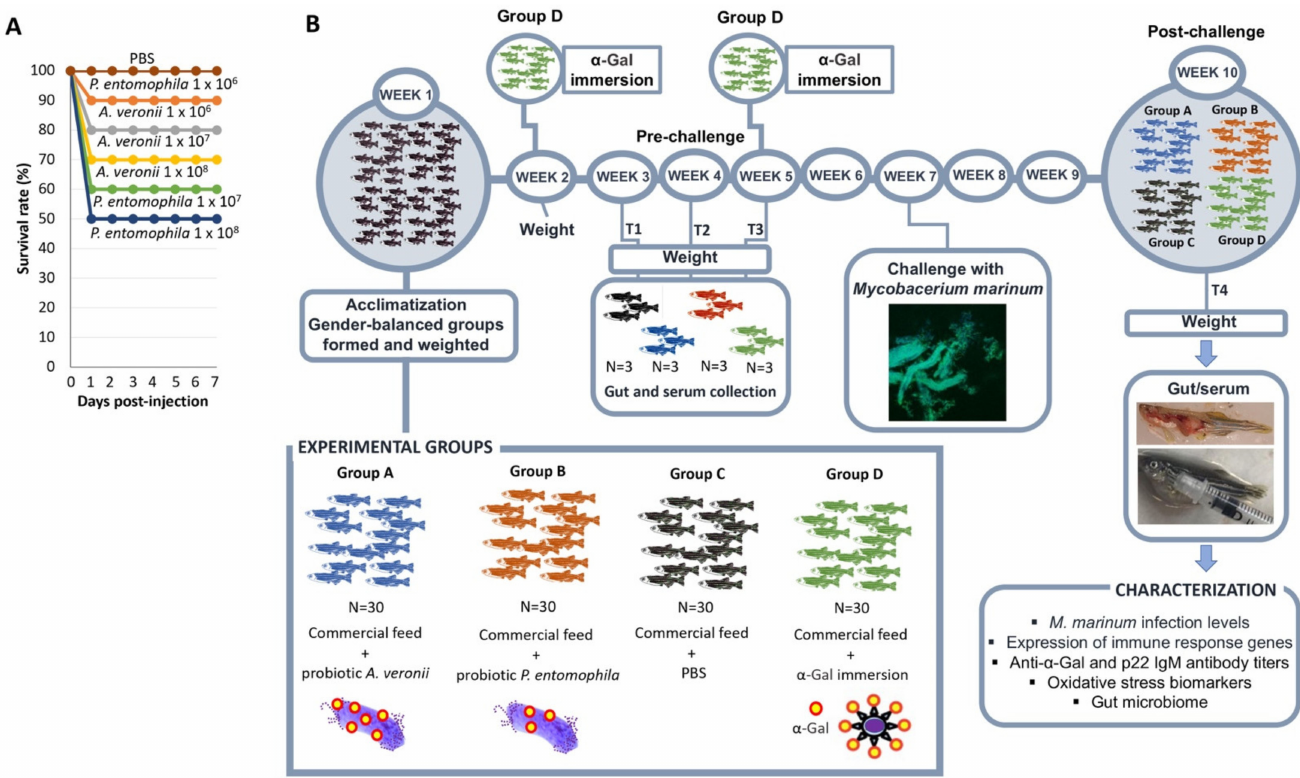
Figure 3. Evaluation of proposed probiotic bacteria in zebrafish. ( A ) Evaluation of bacterial biosafety. Ten fish per group were injected intraperitoneally with 1 × 10 6 , 1 × 10 7 and 1 × 10 8 CFU per fish for both A. veronii and P. entomophila , separately. Fish injected with PBS buffer were used as controls. Bacterial toxicity was evaluated by recording signs and symptoms of infection and mortality of the injected fish daily for 7 days. ( B ) Experimental design for protective response against M. marinum . The effect of immunization with zebrafish gut candidate probiotic bacteria was evaluated with α -Gal and PBS used as positive and negative controls, respectively. Thirty LRZ were randomly allocated to Group A, commercial diet with probiotic A. veronii ; Group B, commercial diet with probiotic P. entomophila ; Group C, commercial diet with PBS; and Group D, commercial diet with α -Gal immersion. Fish were weighted at the weeks 1–5 and 10 at the end of the experiment. Gut and sera were collected at weeks 3 (T1), 4 (T2) and 5 (T3) and at the end of the experiment (week 10; T4) and processed for gut and serum collection for analysis of antibody levels by ELISA, mycobacteria levels by RT-qPCR, expression of selected immune response gene markers by RT-qPCR, oxidative stress biomarkers and gut